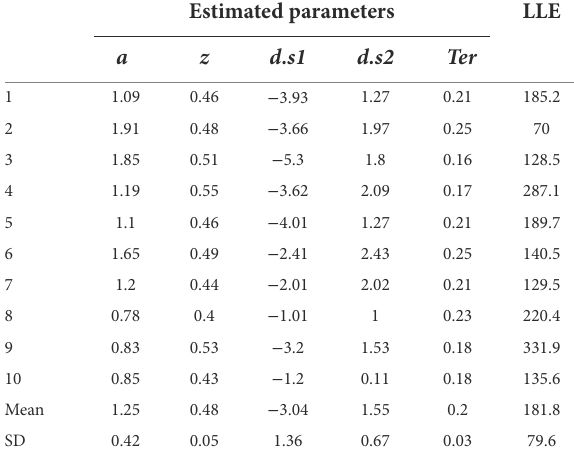
TABLE 4 Parameter estimates obtained from the DDM, using MLE to maximize LLE for each data file separately. Estimated